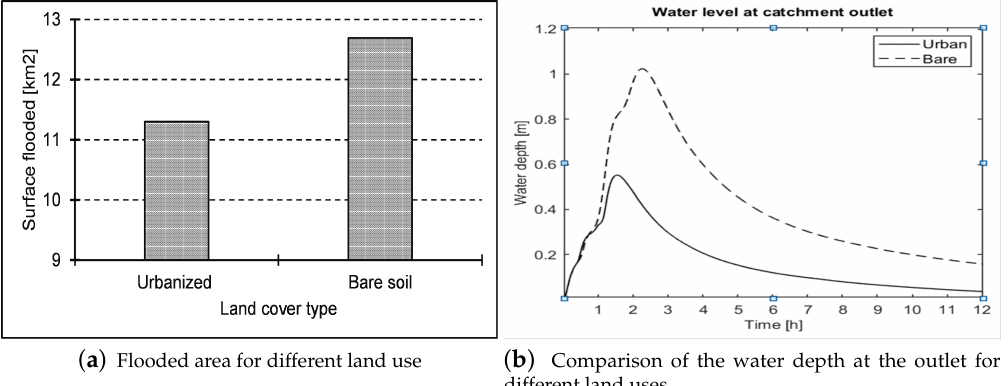
( a ) Flooded area for different land use ( b ) Comparison of the water depth at the outlet for different land uses Figure 9. ( a ) Cumulative area flooded after one hour of uniform synthetic rainfall of 120 mm and ( b ) evolution of water depth at the outlet after 12 h for different land-cover types.